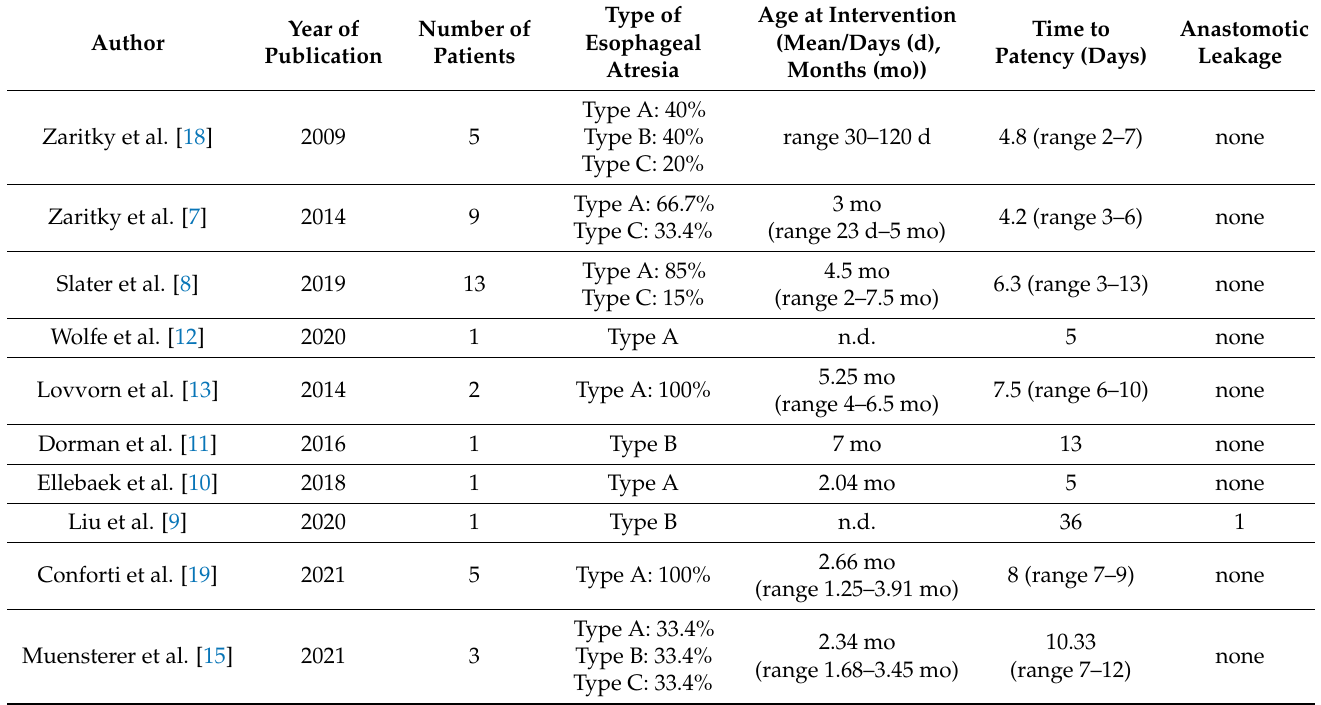
Table 2. Overview of available studies for magnetic esophageal compression